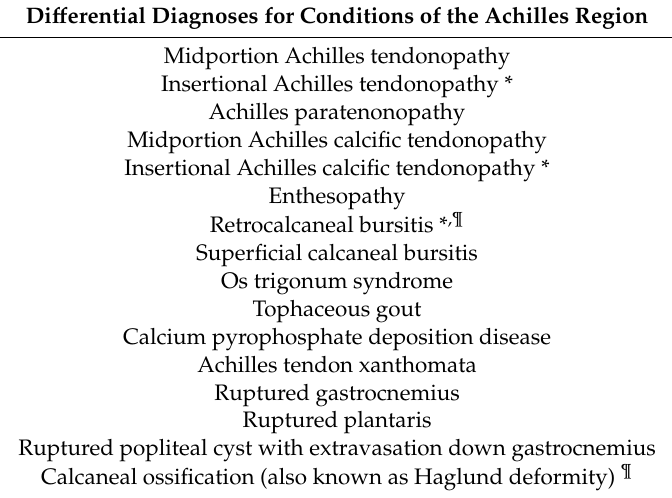
Table 1. Etiologies for hindfoot and posterior ankle pain and / or swelling. Di ff erential Diagnoses for Conditions of the Achilles